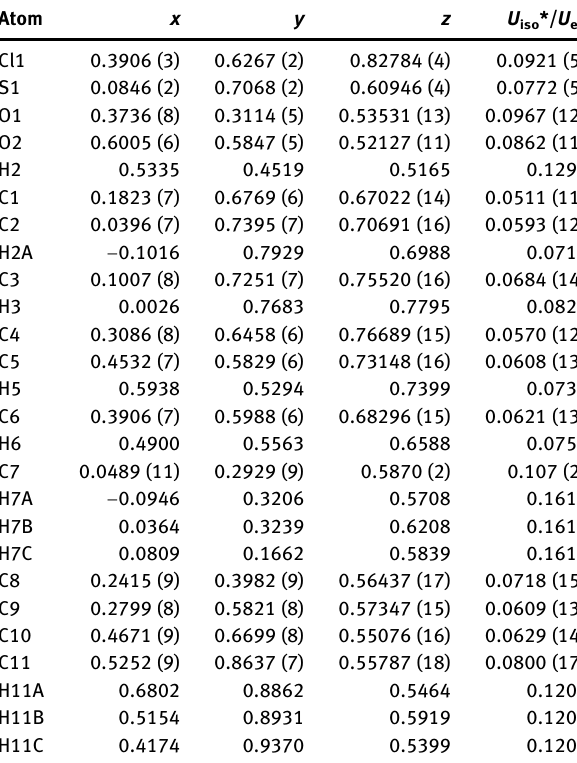
Table  : Fractional atomic coordinates and isotropic or equivalent isotropic displacement parameters (Å 